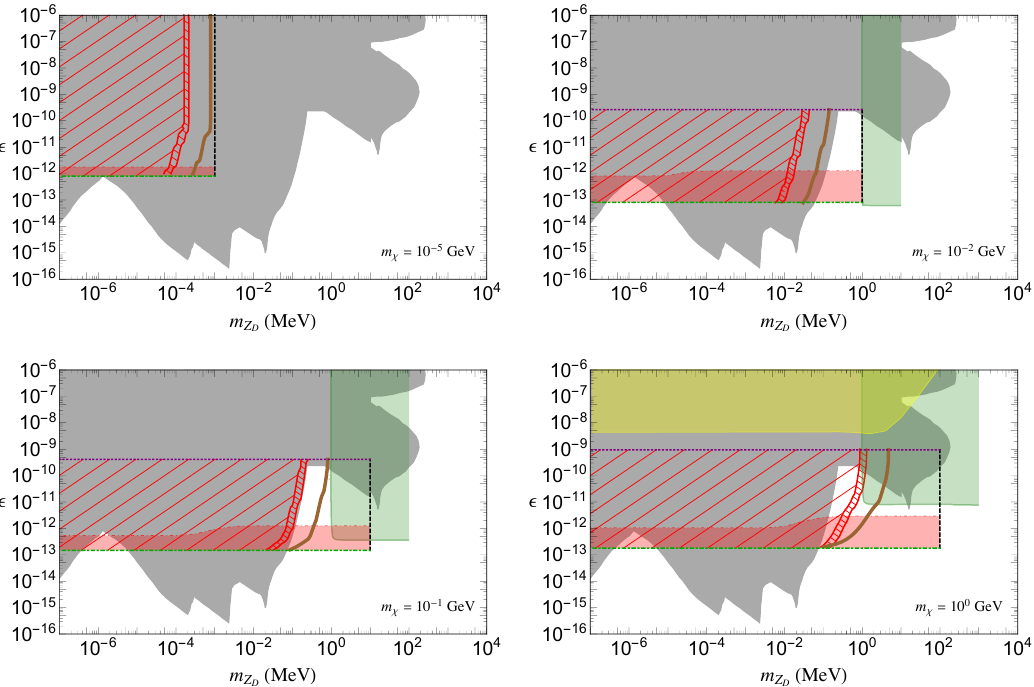
Figure 10. Observational constraints and surviving parameter space for B (cid:0) L leak-in dark matter in the (cid:15) versus m Z plane, for (cid:12)xed choices of m (cid:31) ( Upper left: m (cid:31) = 10 keV; Upper right: D m (cid:31) = 10 MeV; Lower left: m (cid:31) = 100 MeV; Lower right: m (cid:31) = 1 GeV). The dark shaded region shows the constraints on the B (cid:0) L boson ((cid:12)gure 9). The horizontal purple dotted line shows the equilibration (cid:13)oor, the horizontal green dash-dotted line shows the absolute (cid:13)oor, and the vertical dashed black line indicates m Z = 0 : 1 m (cid:31) . The light red region indicates regions that D do not attain full internal thermal equilibrium. Direct detection exclusions are shown in yellow ((cid:12)gure 8), and CMB constraints in green ((cid:12)gure 7). The red hatched region shows regions with h (cid:27) T i =m (cid:31) > 50 cm 2 = g (left curve) and 10 cm 2 = g (right curve), self-consistently computed in the Born regime (section 4.4). Regions to the left of the solid brown line violate the ellipticity bound on DM self-interactions (section 4.4).